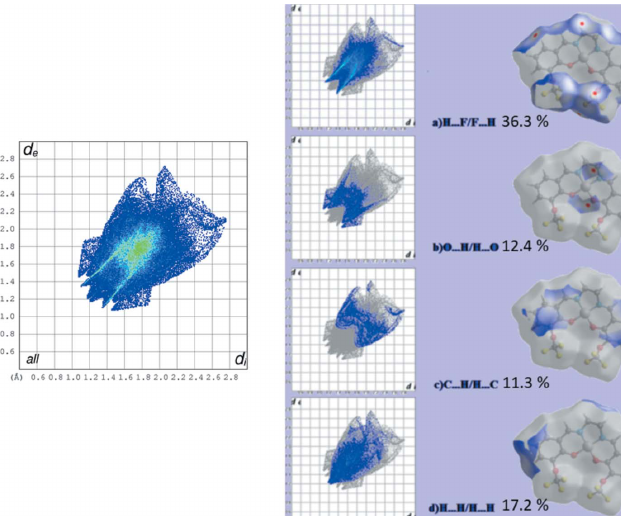
Figure 5 Total two-dimensional fingerprint plot (left) and the individual contribu- tions to the Hirshfeld surface, together with areas of Hirshfeld surfaces involved in the intermolecular contacts (right).